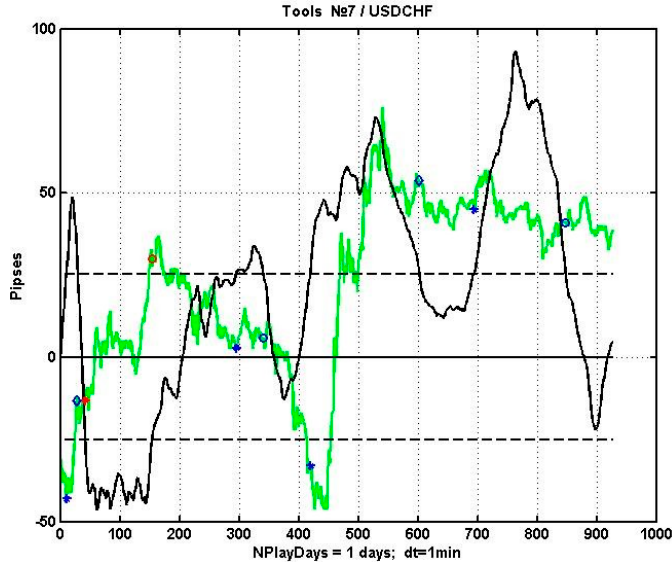
Figure 10. A numerical example of an evolutionally adapted regression asset management algo- rithm.